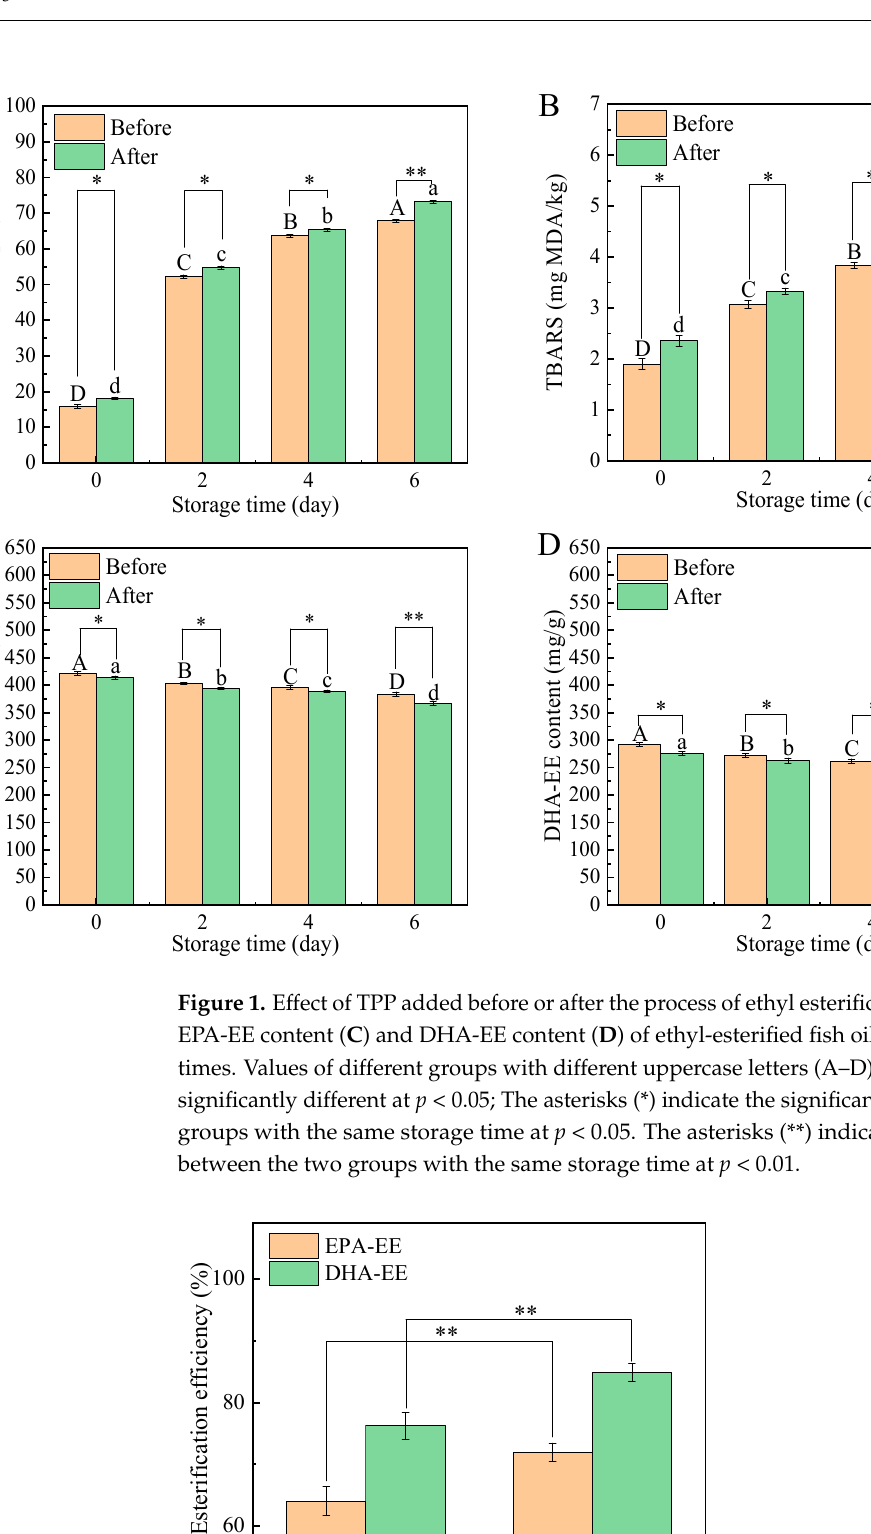
Figure 2. Effect of TPP on the esterification efficiency of fish oil in ethyl esterification. The asterisks (**) indicate the significant differences between the two groups supplemented with the different sample at p <